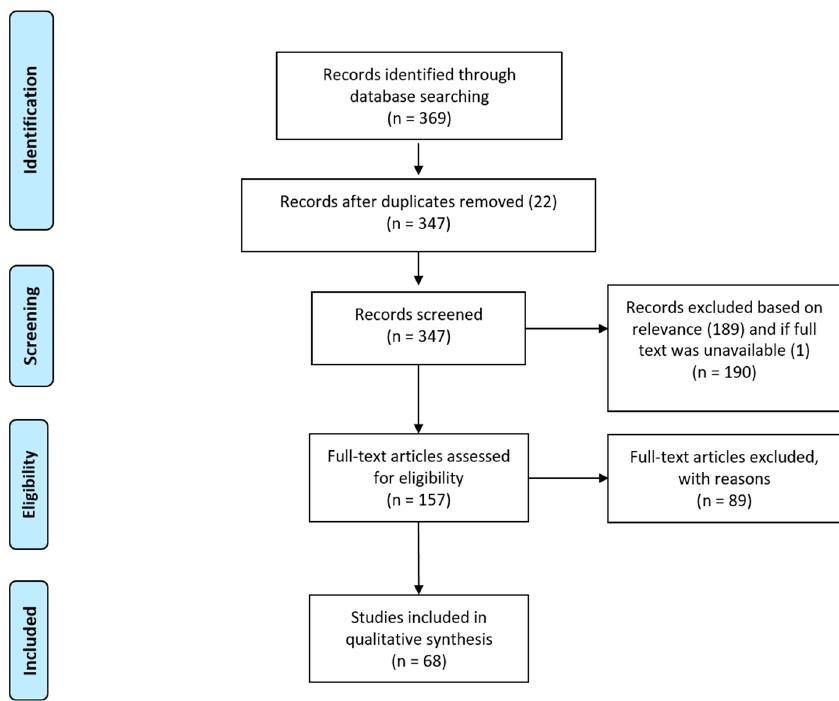
Figure 1. PRISMA flow diagram of the systematic literature review (SLR) process based on the PRISMA flow diagram available from [22].